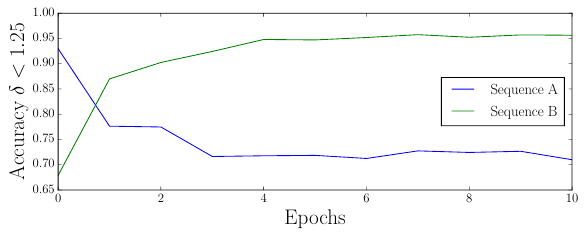
Figure 5. Evaluation of generalization and self-improving capa- bilities. After the network is trained until convergence on Se- quence A, it is evaluated and fine-tuned on a new, yet similar Se- quence B. The graph shows the accuracy achieved by the model on the two datasets during